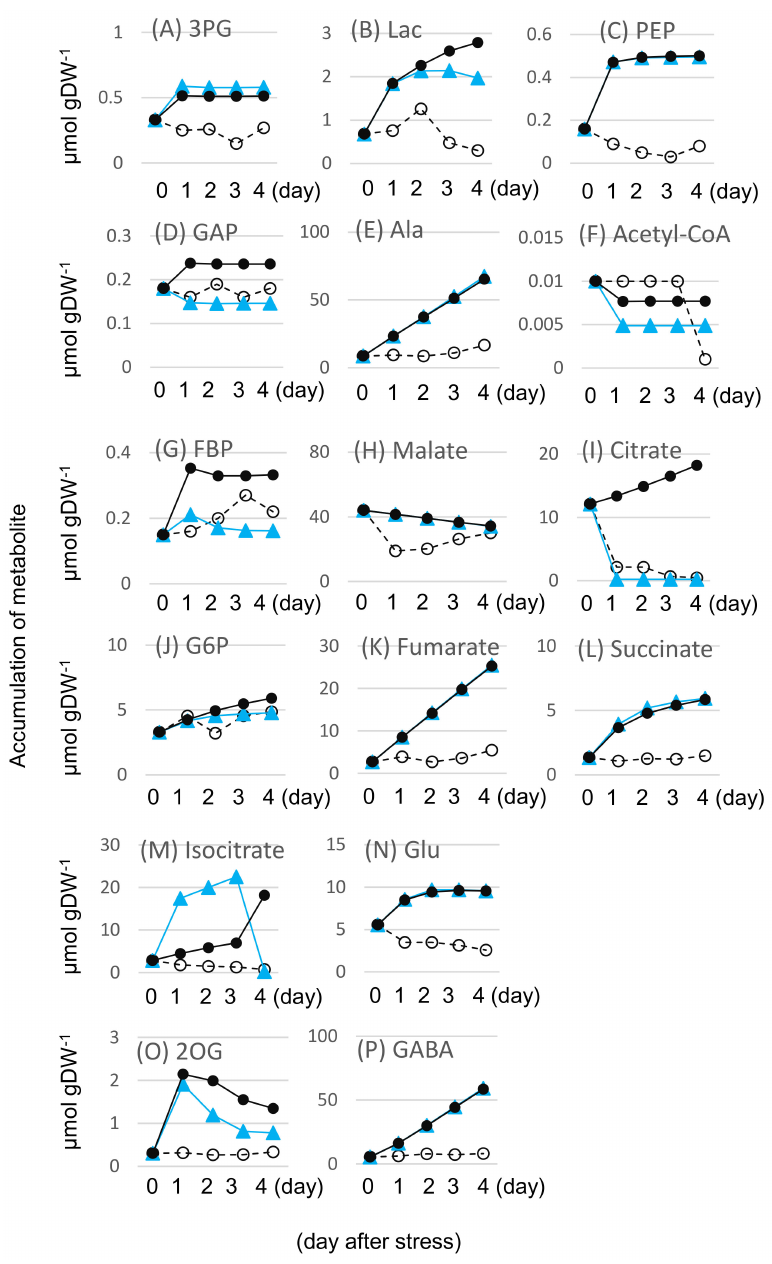
Figure 5. Temporal profiles of 16 metabolites for unstressed and flooding conditions with and without enzyme modification: ( A ) 3PG; ( B ) Lac; ( C ) PEP; ( D ) GAP; ( E ) Ala; ( F ) Acetyl-CoA; ( G ) FBP; ( H ) malate; ( I ) citrate; ( J ) G6P; ( K ) fumarate; ( L ) succinate; ( M ) isocitrate; ( N ) Glu; ( O ) 2OG; ( P ) GABA. In the enzyme modification, overexpression was mimicked by increasing for R1, R28, and R3, 3.2, 1.8, and 1.6 × , respectively, the V max value from its initial value (Table S5). Filled circle and blue triangle indicate simulated profiles under flooding without and with enzyme modification, respectively. Open circle indicates experimental profiles in unstressed conditions. The area below each temporal profile under flooding without and with enzyme modification was measured and was used to calculate metabolite accumulation reduction ratio. Horizontal and vertical axes indicate day-after stress and accumulation of metabolite, respectively. “DW” indicates dry weight of plant. The abbreviations of metabolites are the same as described in the legend of Figure